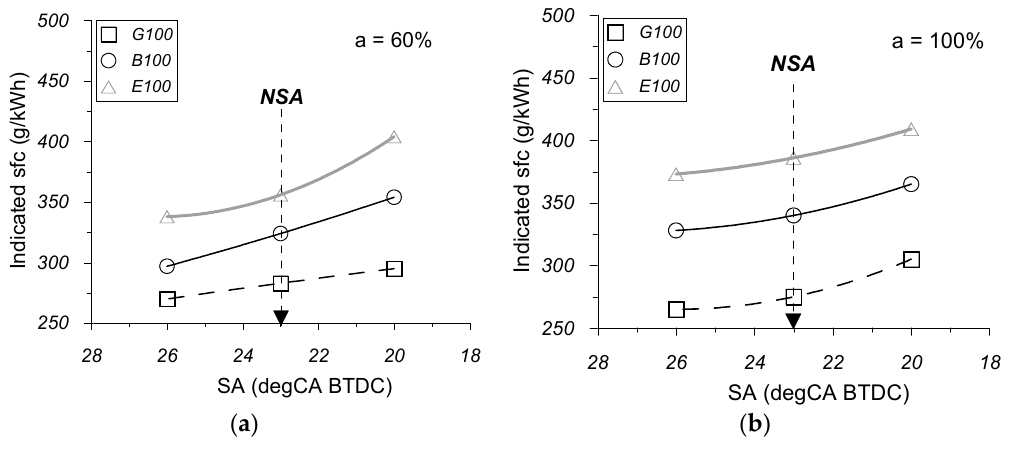
Figure 7. Variation of the calculated indicated specific fuel consumption as a function of the spark advance for G100, B100 and E100 fuel operating modes, at 2400 rpm engine speed and 60% of full load ( a ); and 2400 rpm engine speed and 100% of full load ( b ).